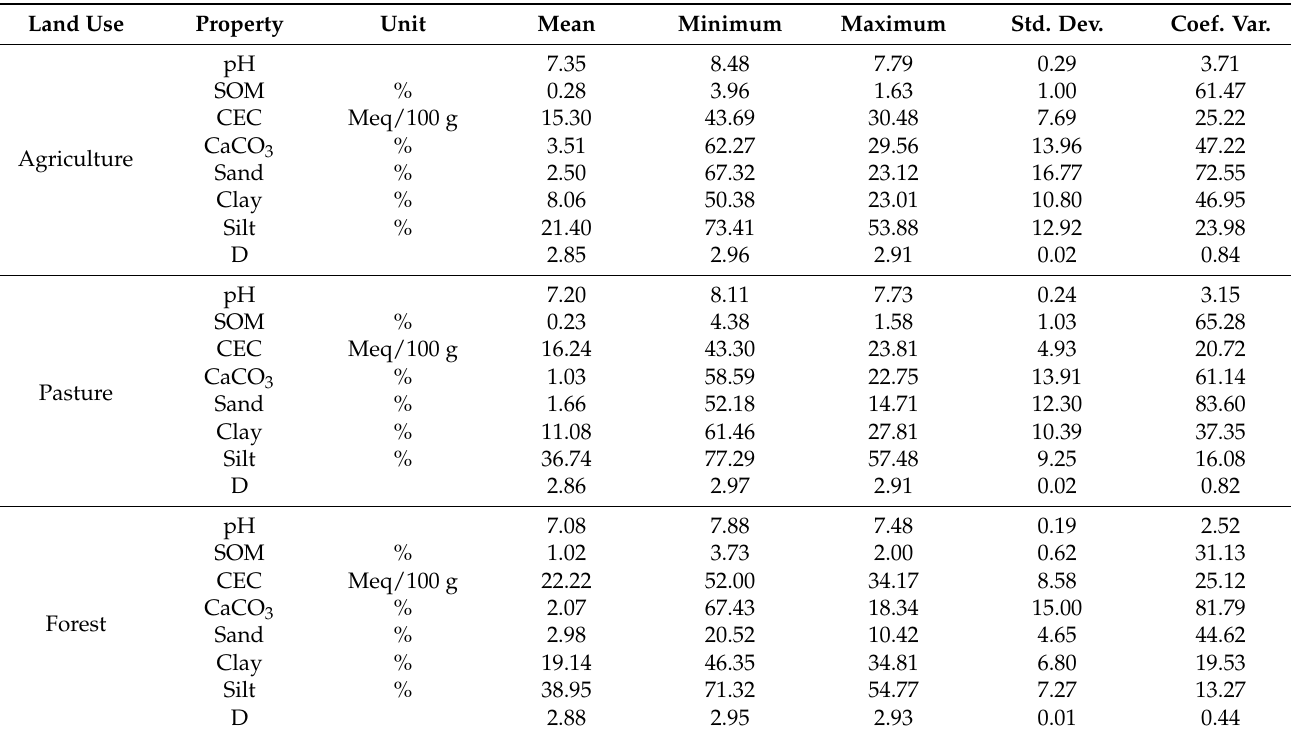
Table 1. Soil property summary statistics (n =